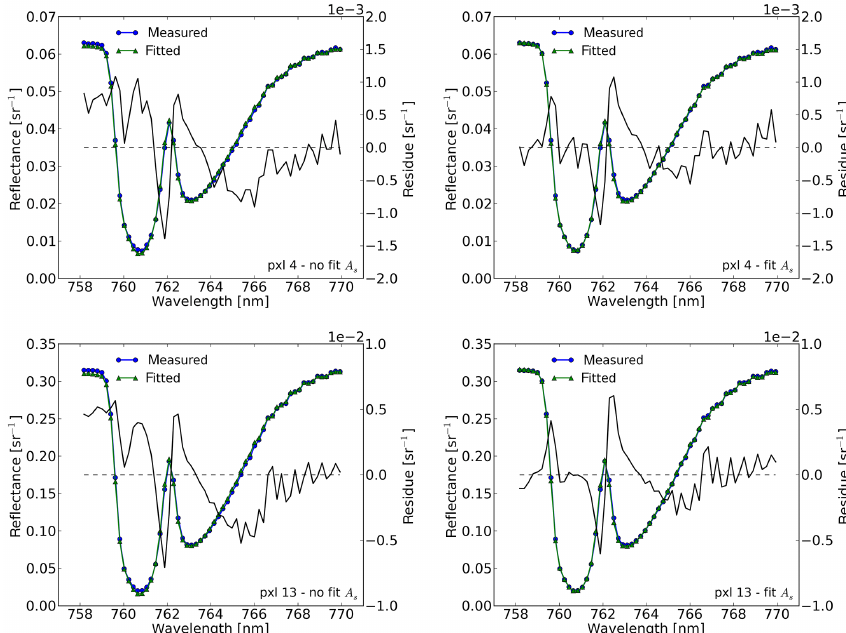
Figure 12. Measured and modeled reflectance spectra for two example GOME-2A target pixels. Top row: pixel over sea (target pixel 04); bottom row: pixel over land (target pixel 13). Left column: surface albedo not fitted; right column: surface albedo fitted. Absolute residues are defined as R meas − R fit . The default retrieval setup of Sect. 7 is used and the run with the smallest χ 2 -value is shown.